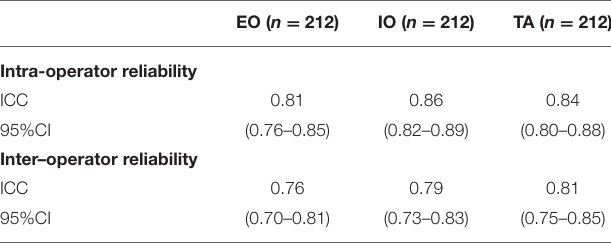
TABLE 3 | Reliability of SWS measured in the three abdominal